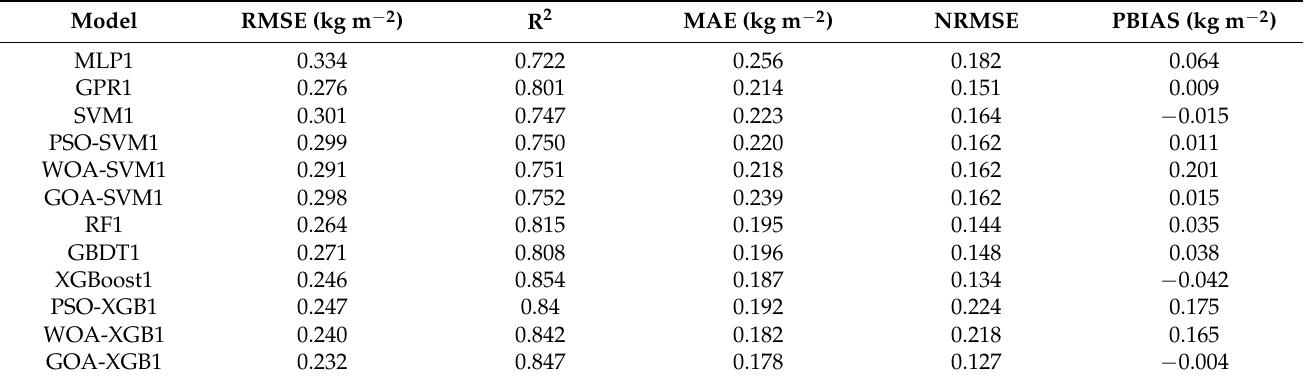
Table 6. Statistics indicators of twelve ML models with all features as